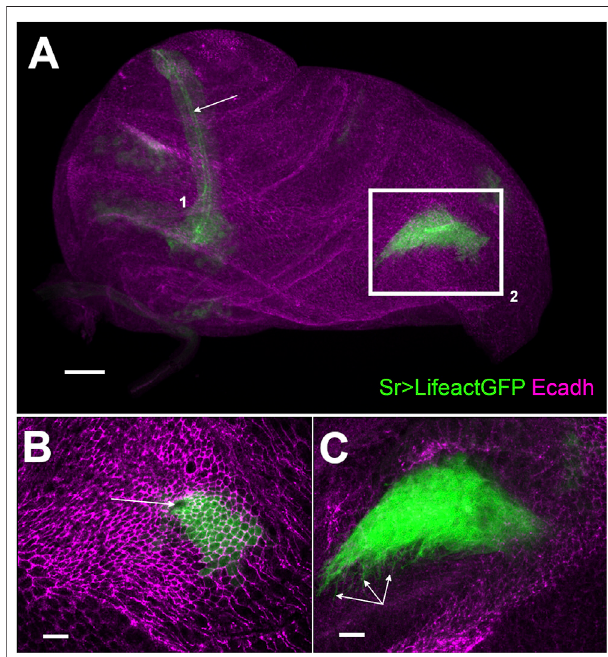
FIGURE 1 | Development of long tendons from 0 h APF leg disc visualized using sr-gal4 driven Lifeact.GFP expression (A) z-projection of selectedopticalsectionsof0 hAPFlegdisc.Long tendonsformfromclusters of epithelial cells (stained with E-cadherin in magenta) expressing sr- gal4 > UAS-Lifeact.GFP (green), long tendon (lt) of the tarsi (1) has elongated from the joint between tarsus T5 and pretarsus. Apical accumulation of Lifeact.GFP outlines the tube lumen (arrow). In the dorsal femur (box 2), the tibia levator long tendon (tilt) has started to invaginate and elongate. Scale bar 30 μ m (B) and (C) Highmagni fi cationofselectedconfocalplanes(frombo × 2). Scale bar 10 μ m (B) Surface view: we can observe apical constriction of Lifeact.GFP cells, revealed by E-cadherin staining, around the invaginating pit (arrow) forming the tube lumen (C) deeper Z planes reveal dense arborization of actin-based fi lopodia at the basal side of the invaginating tendon (arrows).